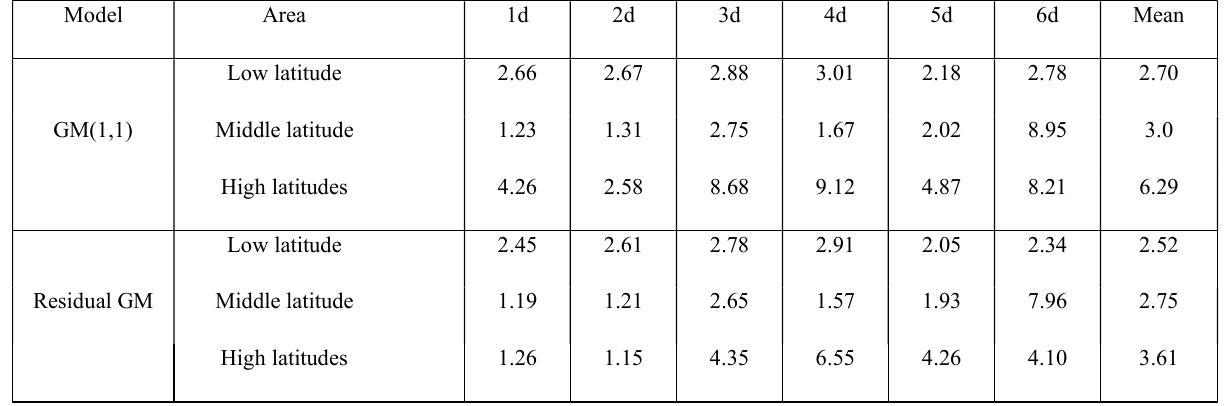
Table 7. RMSE statistics of mean variance in winter forecast Table 4-7 statistics RMSE of the predicted data.